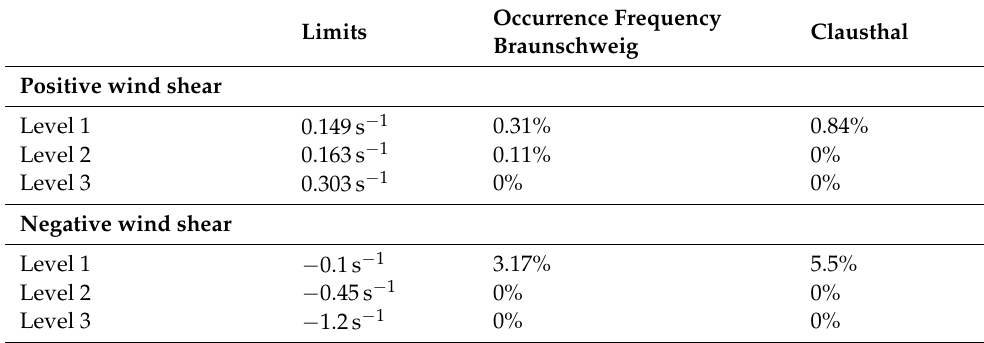
Table 1. Comparison of the measured vertical shear gradients with the hazard potential limits at the landing speed V LD = 70ms − 1 , as specified in [31]. Occurrence Frequency Limits Clausthal Braunschweig Positive wind